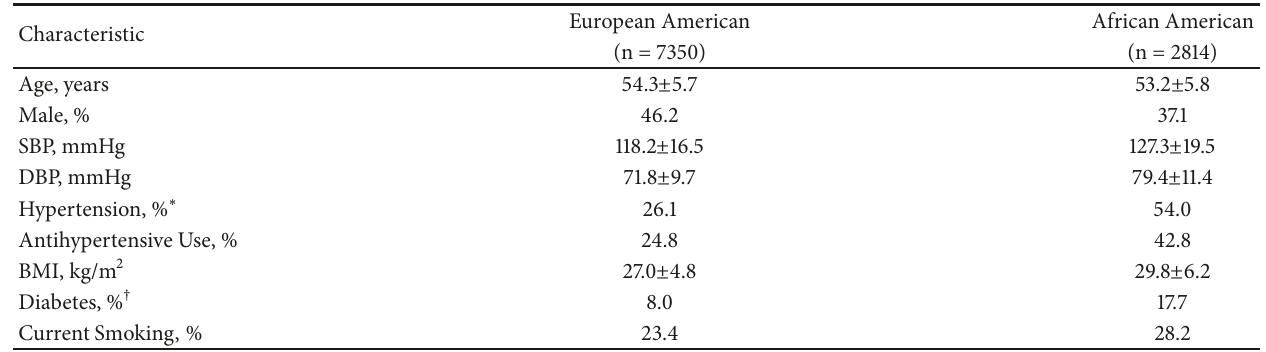
Table 1: Baseline characteristics of study populations.